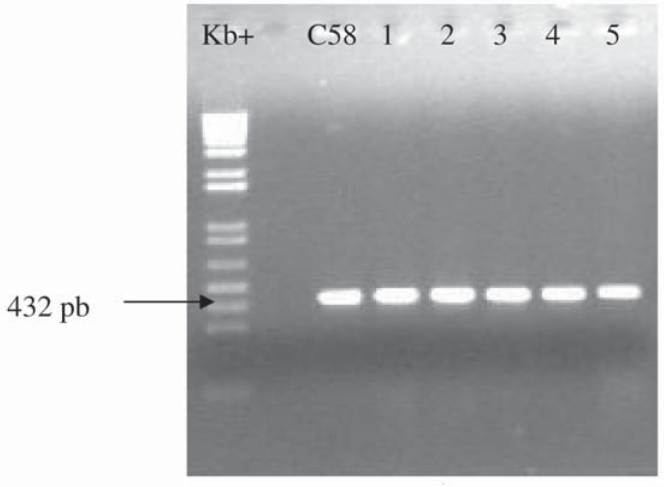
Fig. 1. Agarose gel electrophoresis (0.8%, 80 v) of the virulence region on pTi ( vir B11- vir G15). Lanes 1–5, DNA from selected local isolates: 1, AA8; 2, GF2; 3, Myr3; 4, P125; 5, M8.